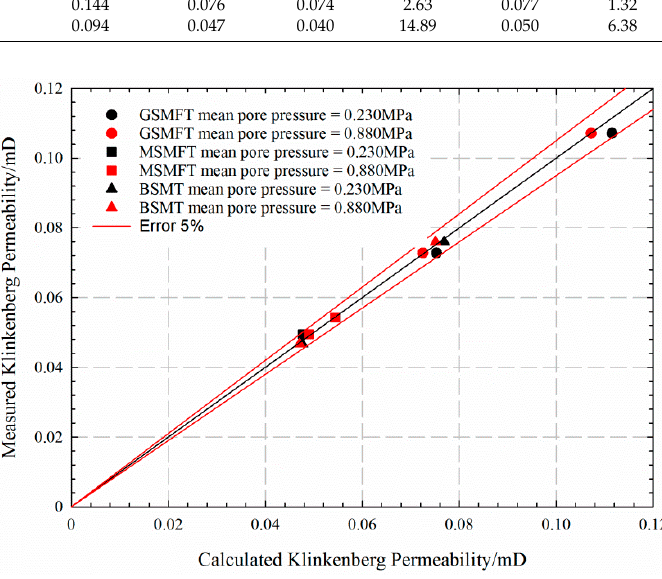
Figure 14. Calculated Klinkenberg permeability using equations versus measured Klinkenberg permeability.